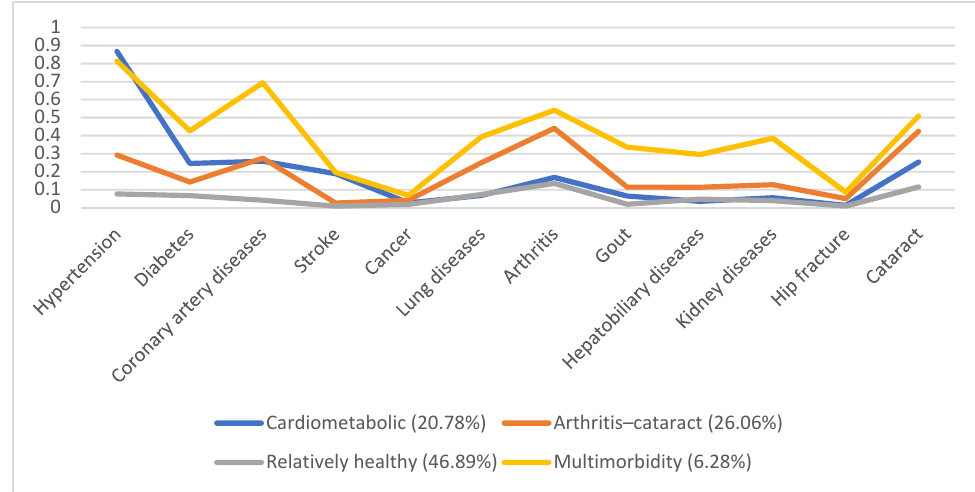
Figure 1. Multimorbidity patterns in 1996.